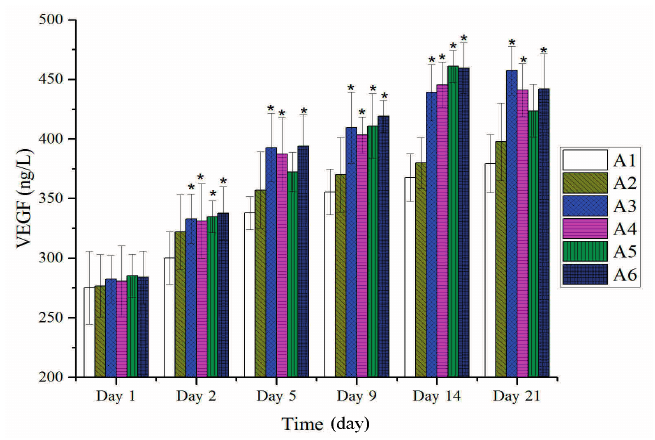
Figure 8. Expressions of VEGF in tissues after treatment with BBO in rats. Values are expressed as mean ± S.D. ( n = 4 animals). * : p < 0.05 vs.